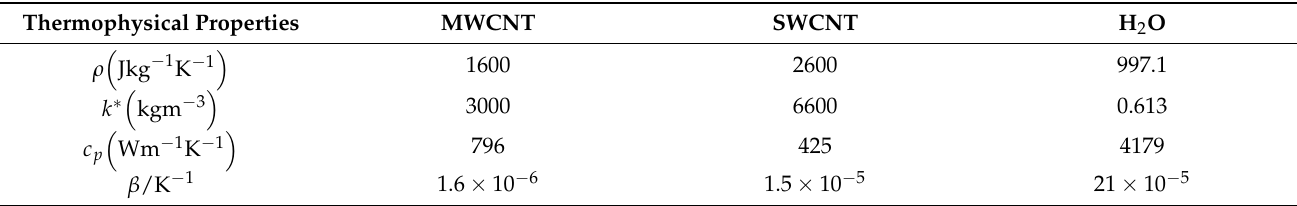
Table 1. The physical properties of the solid nanoparticles and the base fluid.